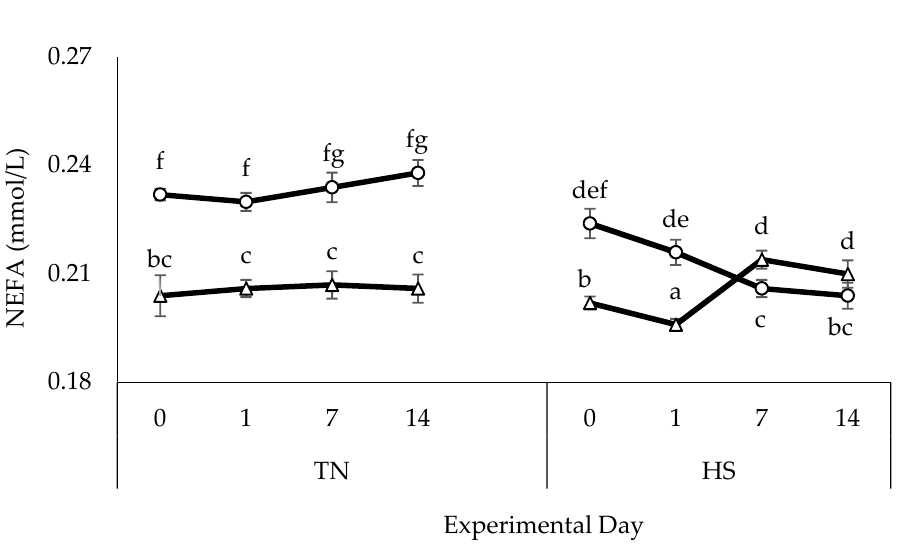
Figure 2. Mean ( ± SEM) non-esterified fatty acid (NEFA) concentrations in Dorper ( ∆ ) and SC ( ) lambs subjected to either TN or HS conditions (n = 12/group). Values with different letters differ significantly for genotype ( p < 0.001) and treatment ( p < 0.01). Genotype × treatment and treatment × day interactions were also significantly ( p < 0.05) different.